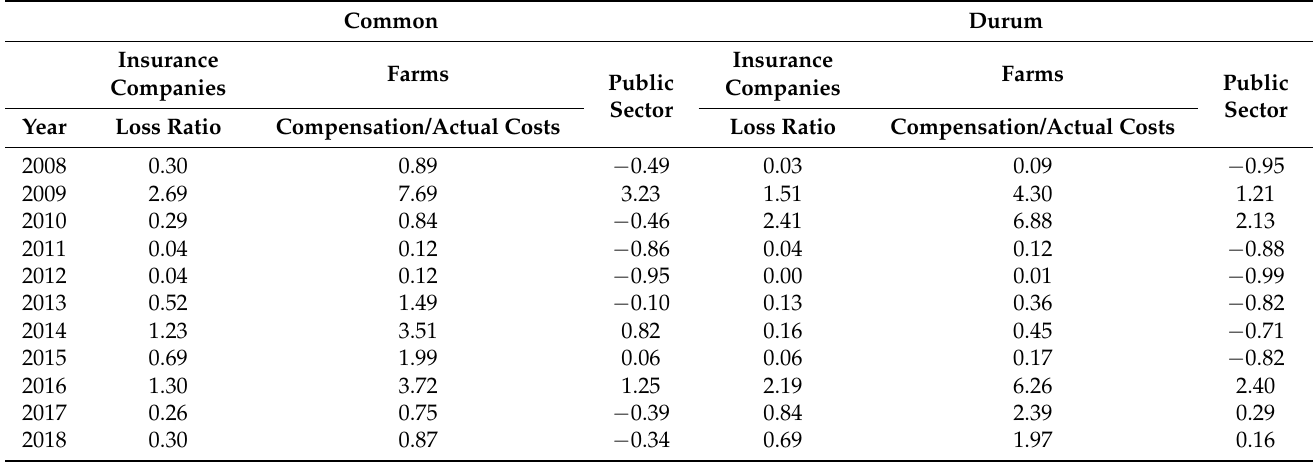
Table 4. Economic convenience indicators: (weighted) means per year are reported for insurance companies and farms, and simple arithmetic mean of PS it is reported for public sector. Common Durum